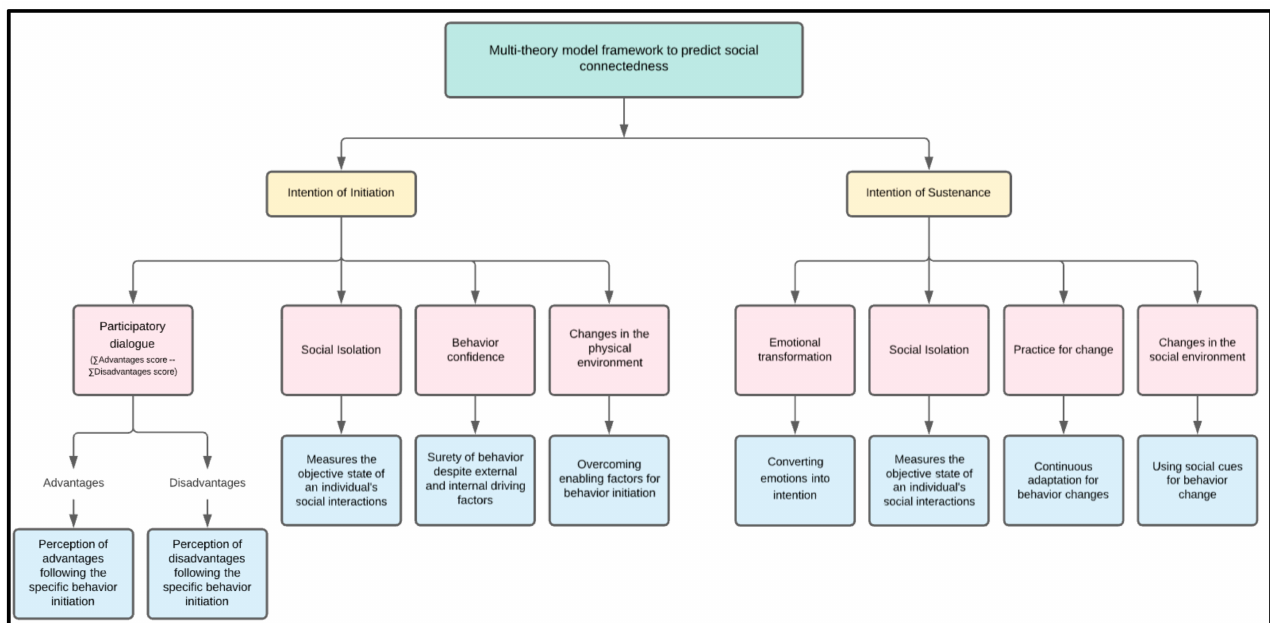
Figure 1. Flowchart detailing multi-theory model framework to predict social